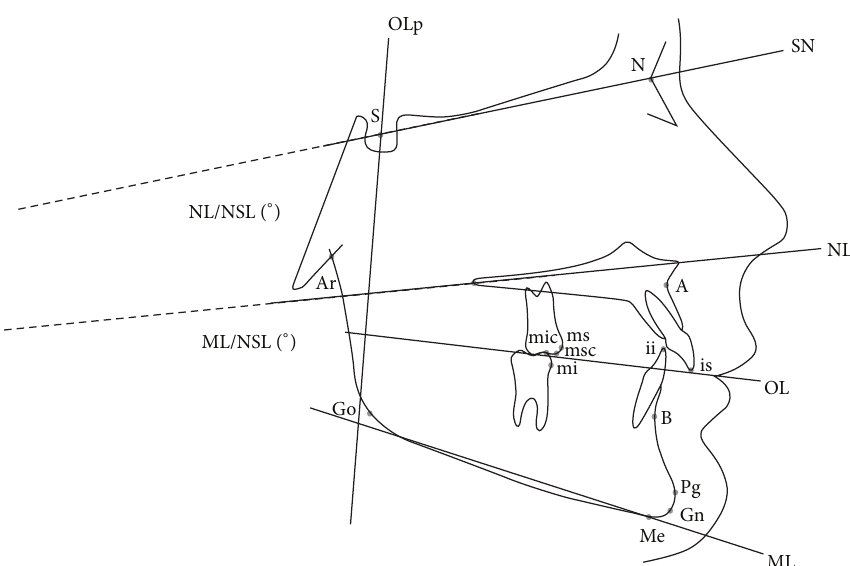
Figure 1: Cephalometric landmarks (for details please see [2, 19]). Cephalometric reference lines are OL: maxillary occlusal plane, the line joining the distobuccal cusp tip of the maxillary permanent first molar and the upper incisor tip, is, and OLp: occlusal plane perpendicular to OL through S. Sagittal variables: overjet (mm): is-OLp minus ii-OLp; mandibular length (mm): Ar-Gn; maxillary prognathism: A-OLp (mm) and S-N-A ( ∘ ); mandibular prognathism: Pg-OLp (mm) and S-N-B ( ∘ ); jaw base relationship: A-Pg (mm), A-N-B ( ∘ ), and A, B on functional occlusal plane (mm); upper and lower incisor changes: is-A (mm), is-OLp minus A-OLp and ii-Pg (mm), ii-OLp minus Pg-OLp; upper and lower first molar changes: ms-A (mm), ms-OLp minus A-OLp and mi-Pg (mm), mi-OLp minus Pg-OLp; and molar relationship: ms-mi (mm), ms-OLp minus mi-OLp. Vertical variables: overbite (mm): ii-OL; upper face height (mm): N-NL; lower face height (mm): NL-Me; total face height (mm): NSL-Me; upper and lower incisor changes (mm): is-NL and ii-ML; upper and lower first molar changes (mm): msc-NL and mic-ML. Rotational changes ( ∘ ): NSL/NL and